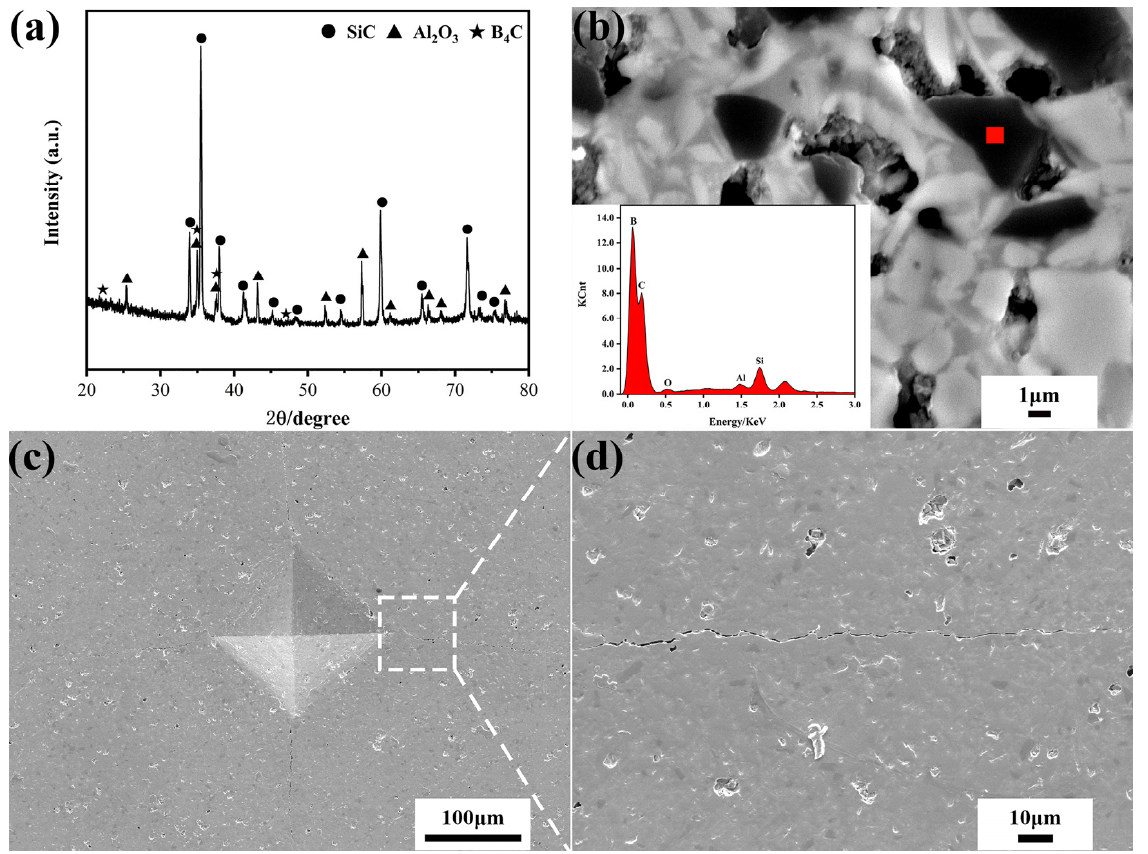
Figure 1. ( a ) X-ray diffraction pattern, back-scattering electron micrographs of phase composition ( b ) Vickers indentation ( c ) and crack ( d ) of SiC-Al 2 O 3 -B 4 C ceramic composite.